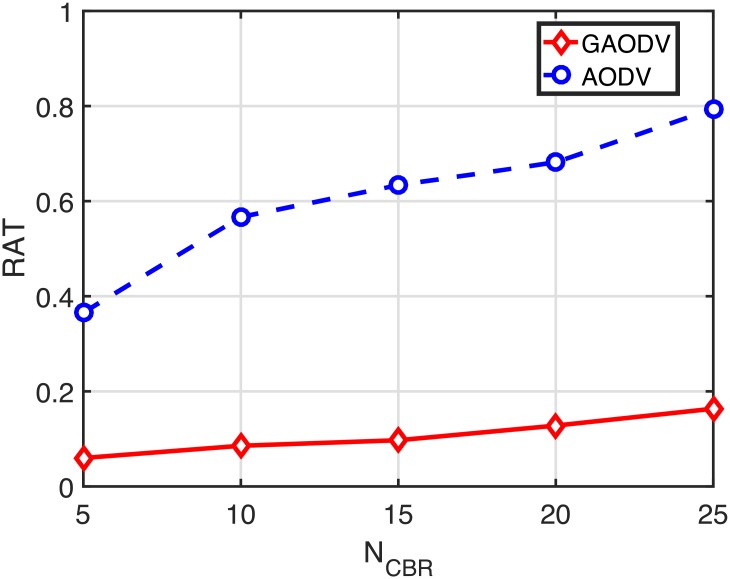
Route acquisition time for the change of NCBR when vmax = 5 m/s.